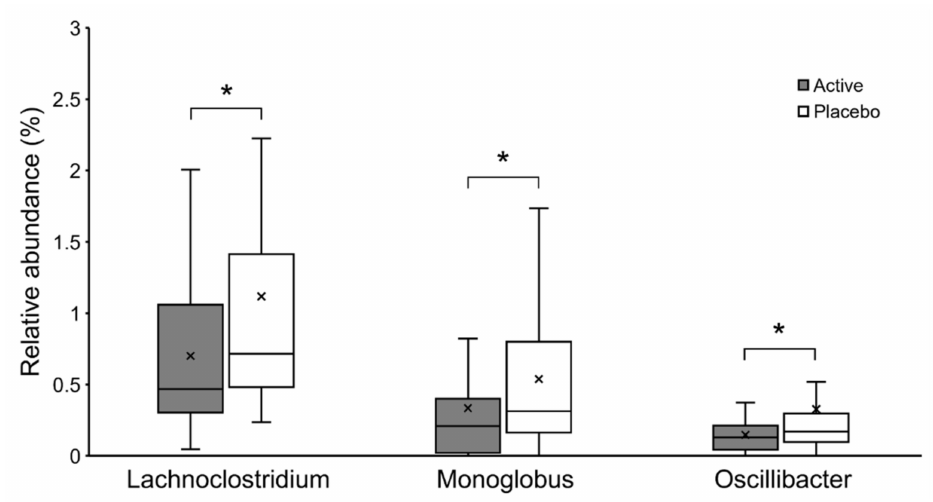
Figure 3. The relative abundance of Lachnoclostridium, Monoglobus, and Oscillibacter shown in Box-and-whisker diagram. * p <